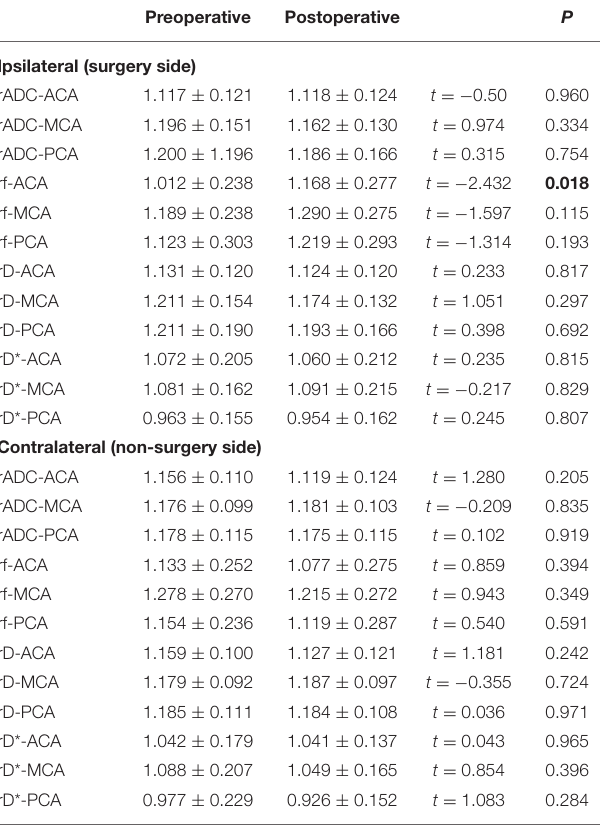
TABLE 4 | Postoperative microvascular perfusion changes of patients with MMD (33 cases).